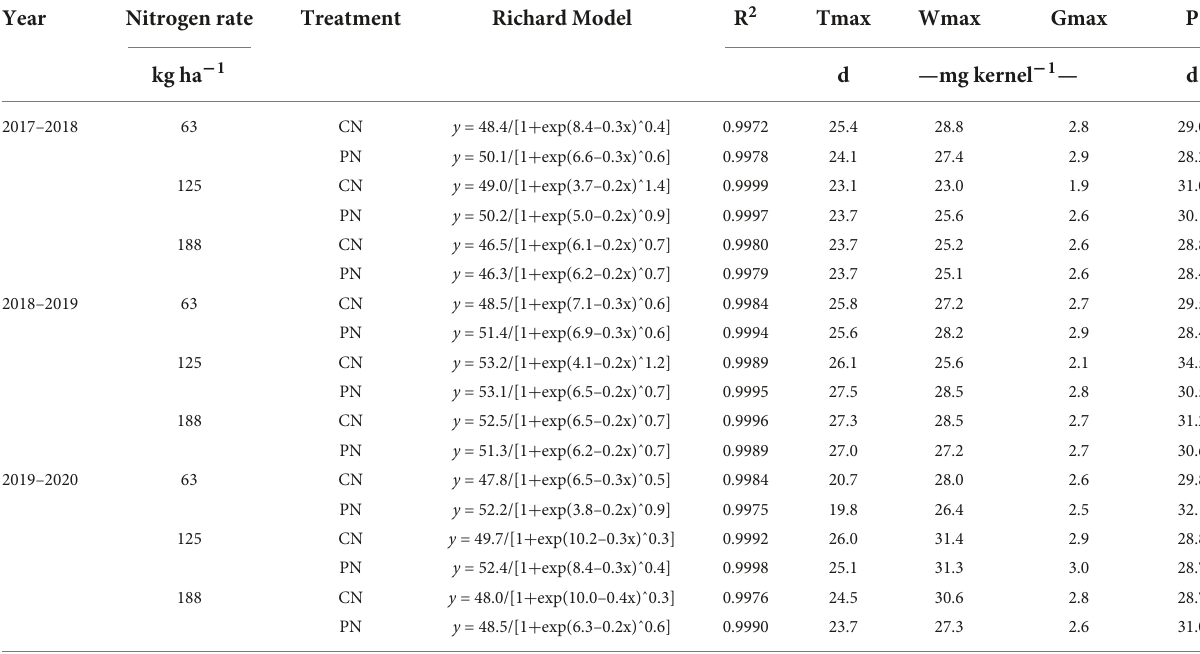
TABLE 5 Grain-filling characteristics of wheat kernels at three N rates under the control (CN) and poly(aspartic acid)-coated urea (PN) treatments from 2017 to 2020. Year Nitrogen rate